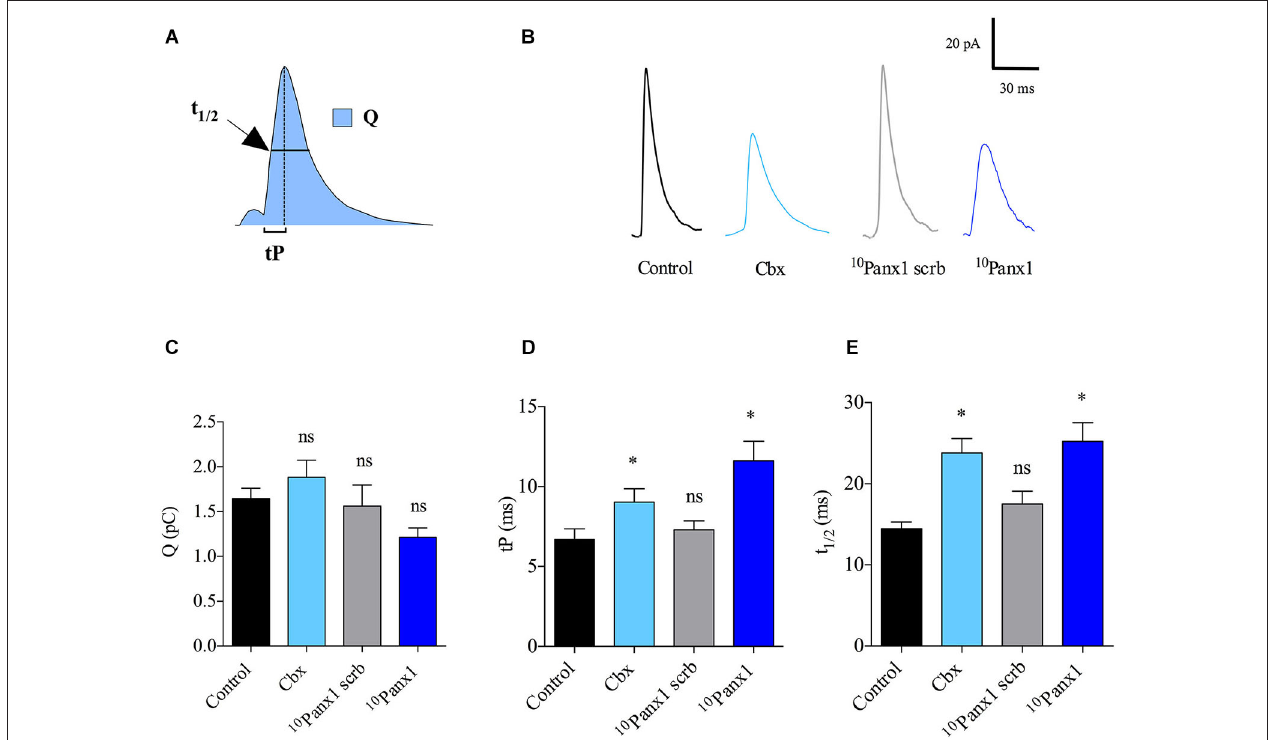
peptide ( n = 25) from three to five different cultures. Parameter values correspond to the mean values of the events from individual cells, thus “n” corresponds to the number of cells analyzed in each group. * p < 0.05 (Mann-Whitney test) compare with control cells. Note that treatment of chromaffin cells with the Panx1 channel inhibitors did not affect Q (C) , but slows down the kinetics of single exocytotic events, as observed by an increase of tP (D) and t 1 / 2 (E) . ns = non-significant, * p < 0.05 (Krukal-Wallis